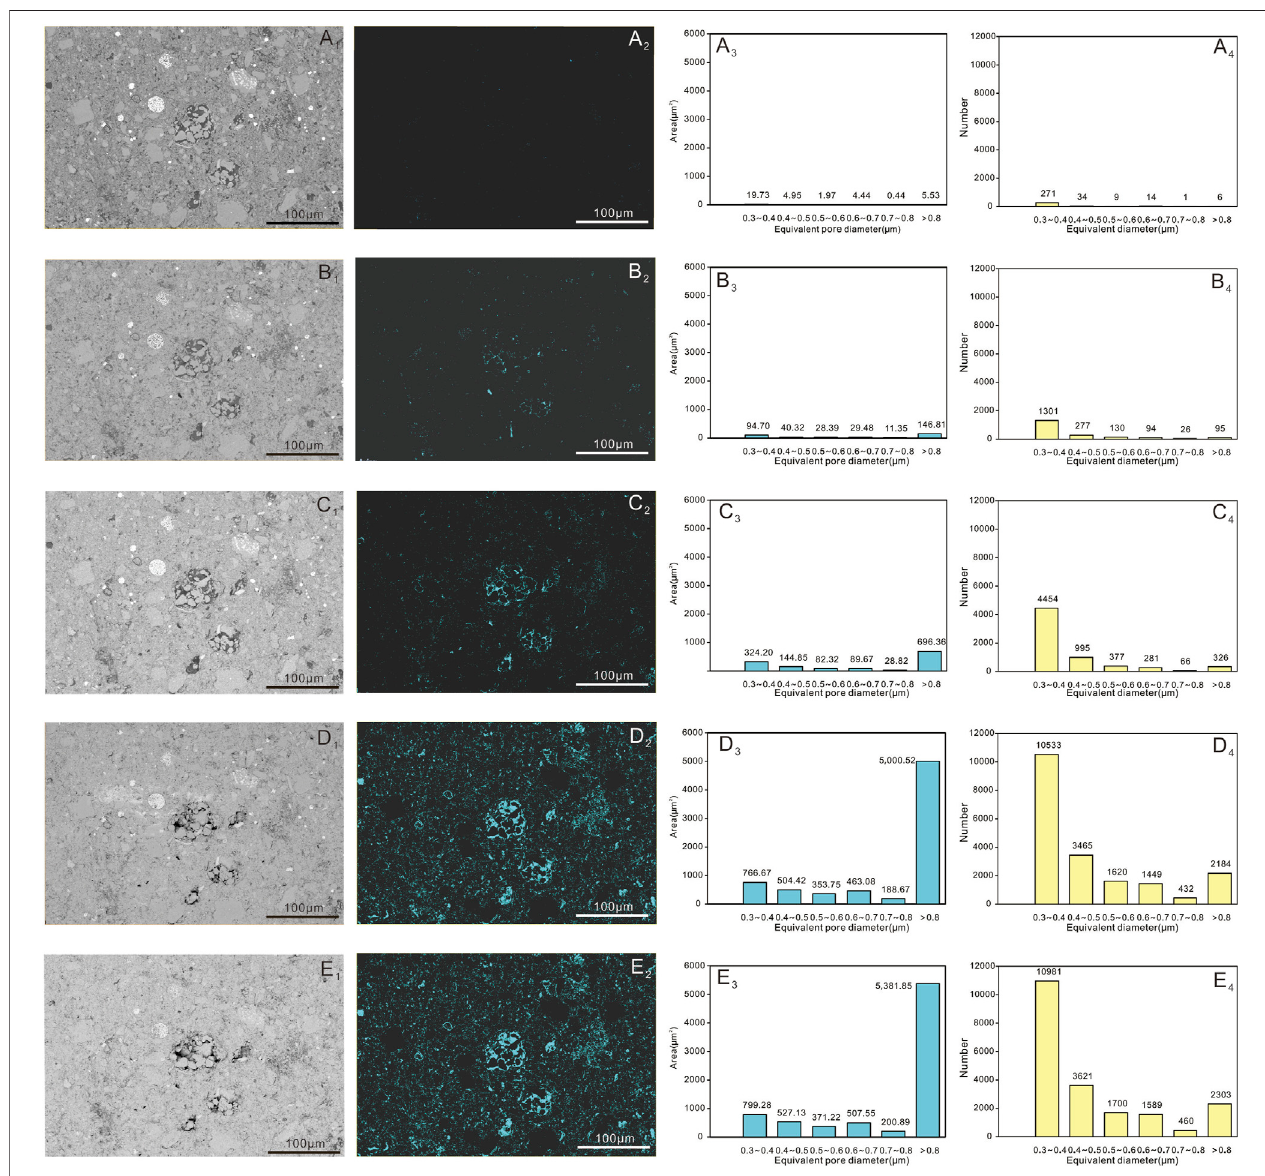
FIGURE7| Planeporosityofshalesamplesatdifferenttemperaturesshownbyimageanalysis. (A) seriesareoriginalsamples, (B) seriesaresamplesat250 ° C, (C) series are samples at 350 ° C, (D) series are samples at 450 ° C, and (E) series are samples at 550 ° C.